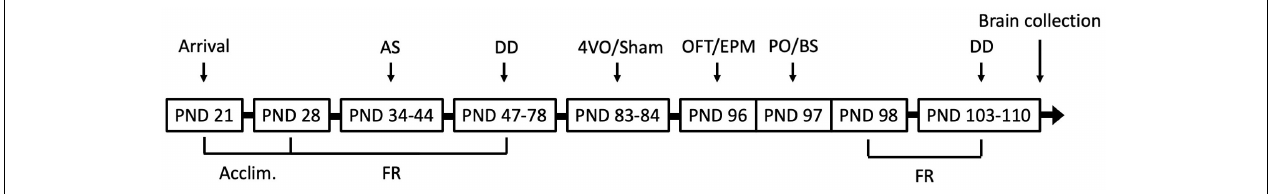
FIGURE 1 | Experimental timeline. Rats were acclimated for 7 days prior to start of food restriction (FR). Autoshaping (AS) and delay discounting (DD) occurred 5 days per week, for 9 and 24 days, respectively. Four-vessel occlusion (4VO) and sham (Sh) surgeries were performed when rats were 83 and 84 days old. Behavioural testing took place following 11 days of recovery and consisted of the Open Field Test (OFT), Elevated-Plus Maze (EPM), and Predator Odour Test (PO) with blood sampling (BS), after which FR was resumed. Rats completed six DD sessions and were perfused immediately after the last session. PND, Postnatal Day.